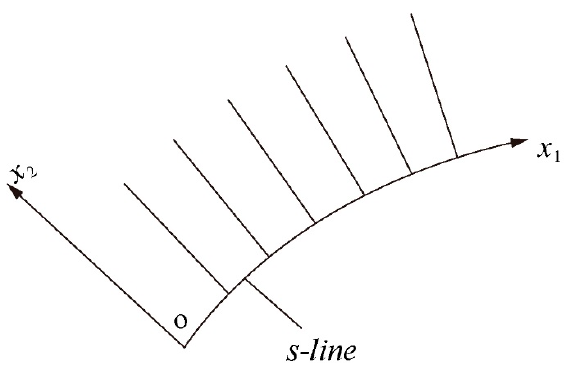
( ) , x x near a given curve (S – line) under plane strain 1 2